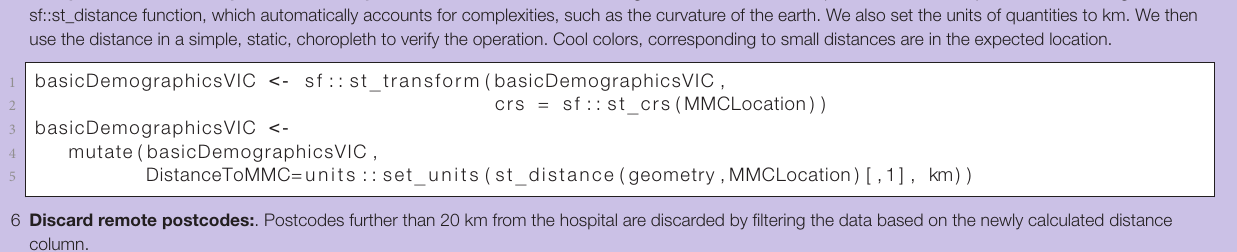
TABLE 2 | Steps 5-7 in computation of interactive display of choropleth of estimated stroke incidence. 5 Compute distance from postcode to hospital: We create a column containing the distance from each postcode to the hospital of interest using the sf::st_distance function, which automatically accounts for complexities, such as the curvature of the earth. We also set the units of quantities to km. We then use the distance in a simple, static, choropleth to verify the operation. Cool colors, corresponding to small distances are in the expected